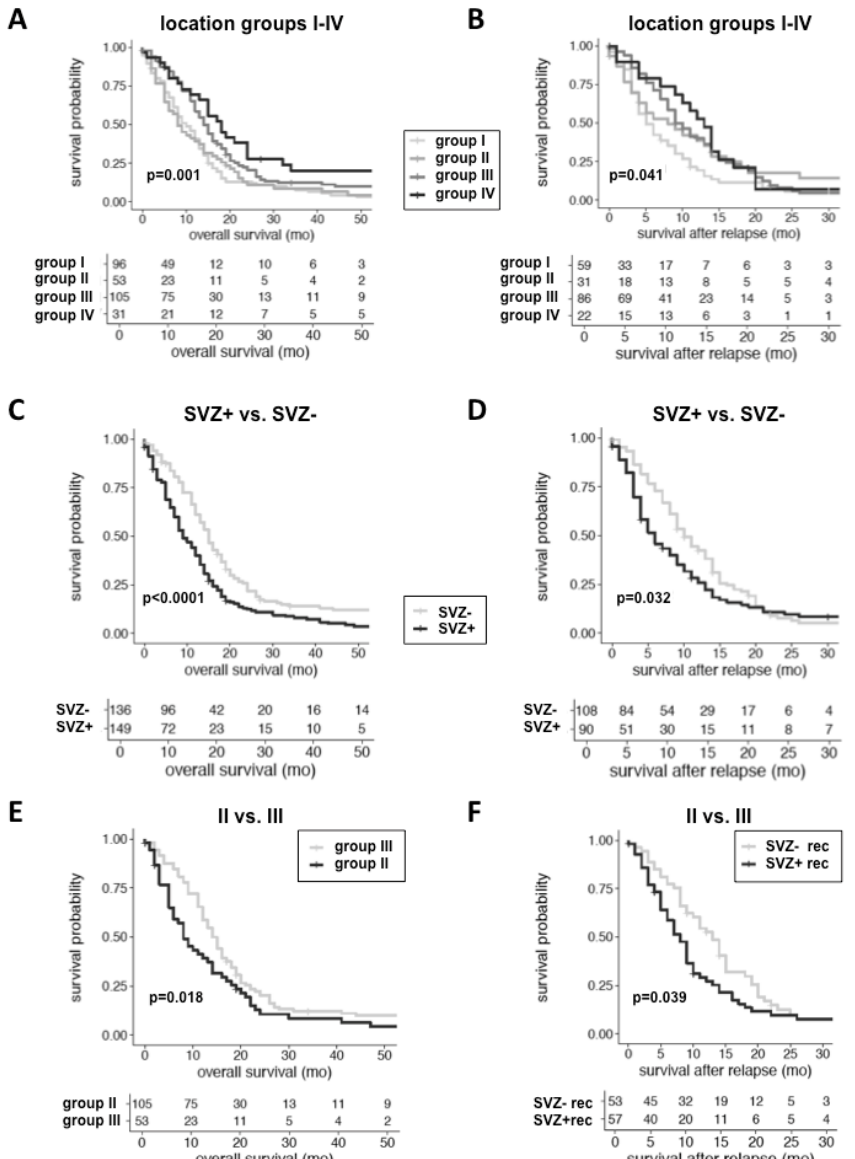
Figure 3. Kaplan-Meier plots depicting the negative prognostic impact of SVZ involvement in 285 IDH1-wt GBM patients; numbers at risk are given. OS and survival after relapse, but not PFS differed significantly when comparing all location groups ( A , B ), SVZ+ vs. SVZ − GBMs ( C , D ) and group II vs. group III GBMs ( n = 155) ( E , F ). Shortest median OS and survival after relapse were observed in group I (10 and 5 months) and group II (8 and 6 months) patients. For comparison of survival after relapse in group II vs. group III GBMs, SVZ involvement at recurrence (SVZ+/ − rec) was valued.